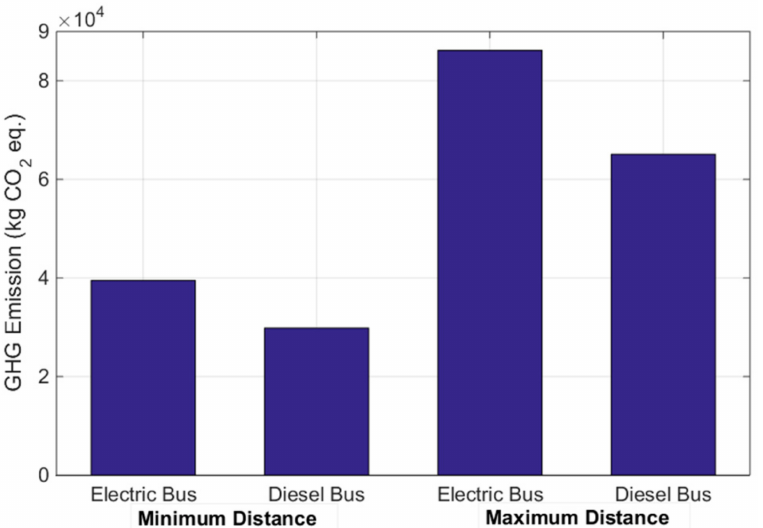
Figure 13. Diesel and electric bus emissions during the operational phase for the minimum distance and maximum distance